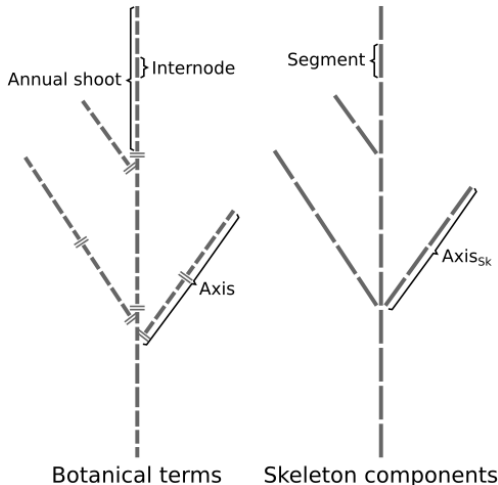
Figure 1. Illustration of the differences between the botanical term ( left ) and the terms used to describe the skeleton components ( right ). On the left, = corresponds to the annual shoot